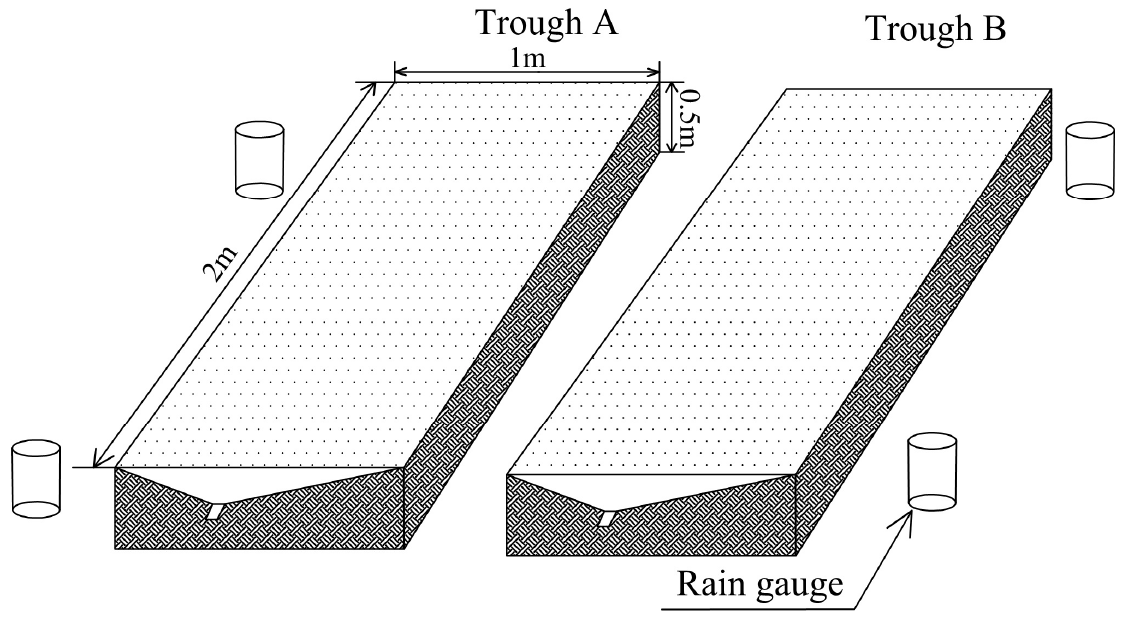
Figure 2. Experimental setup of rainfall simulation experiment with two parallel 2 m × 1 m × 0.5 m troughs.